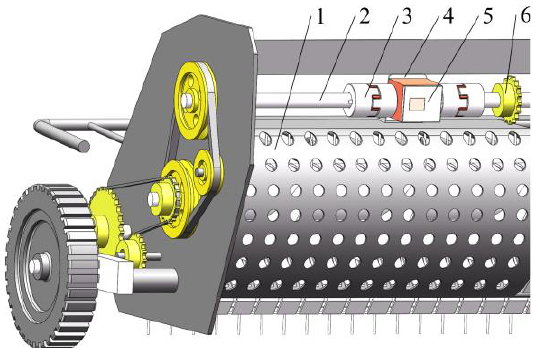
Figure 3. Sensor installation diagram: ( 1 ) rear protective plate of the pickup platform; ( 2 ) separate power input shaft; ( 3 ) coupling; ( 4 ) installation bracket; ( 5 ) torque and rotational speed sensor; ( 6 ) transmission gear.